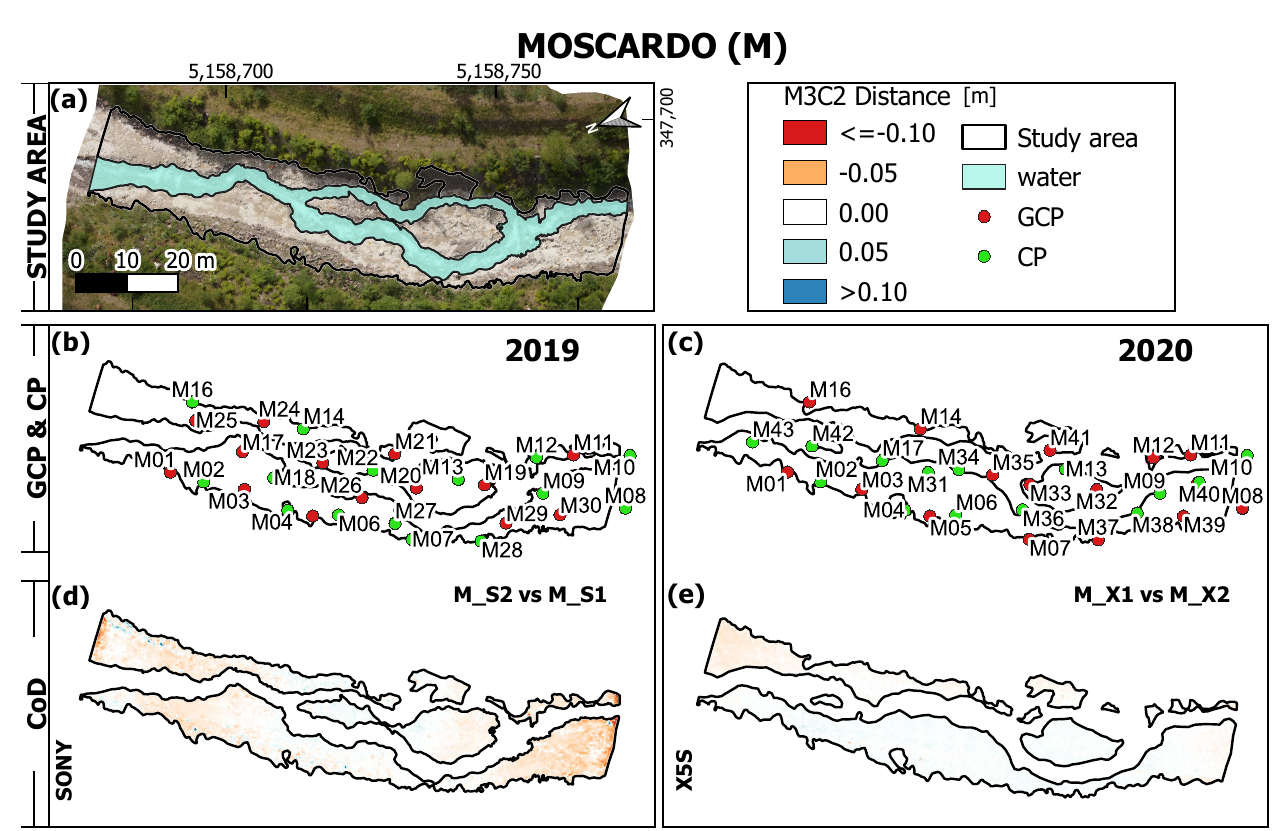
Figure 5. CoDs of Moscardo models. Evaluated datasets were collected in different years using different cameras. ( a ) Study area (water have been removed to avoid biased comparisons). ( b , c ) GCPs (red) and CPs (green) positions for 2019 and 2020 surveys. ( d ) CoD derived from the comparison between M_S1 and M_S2 . ( f ) CoD computed between X5S surveys ( M_X1 vs M_X2 ). Distance values are pictured with a red-to-blue